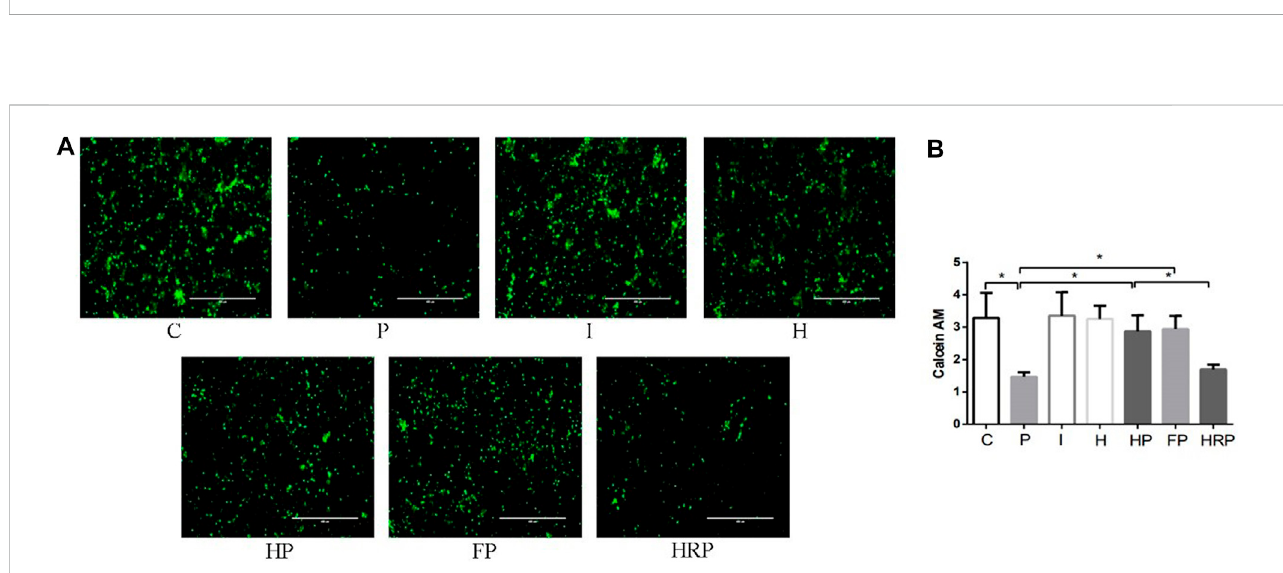
FIGURE 6 Cellviabilityinprimaryhippocampalneuronsexposedtopropofolwithorwithouthypoxicpreconditioning,inhibitororagonist. (A,B) CalceinAMineach group (one-way ANOVA, * p <